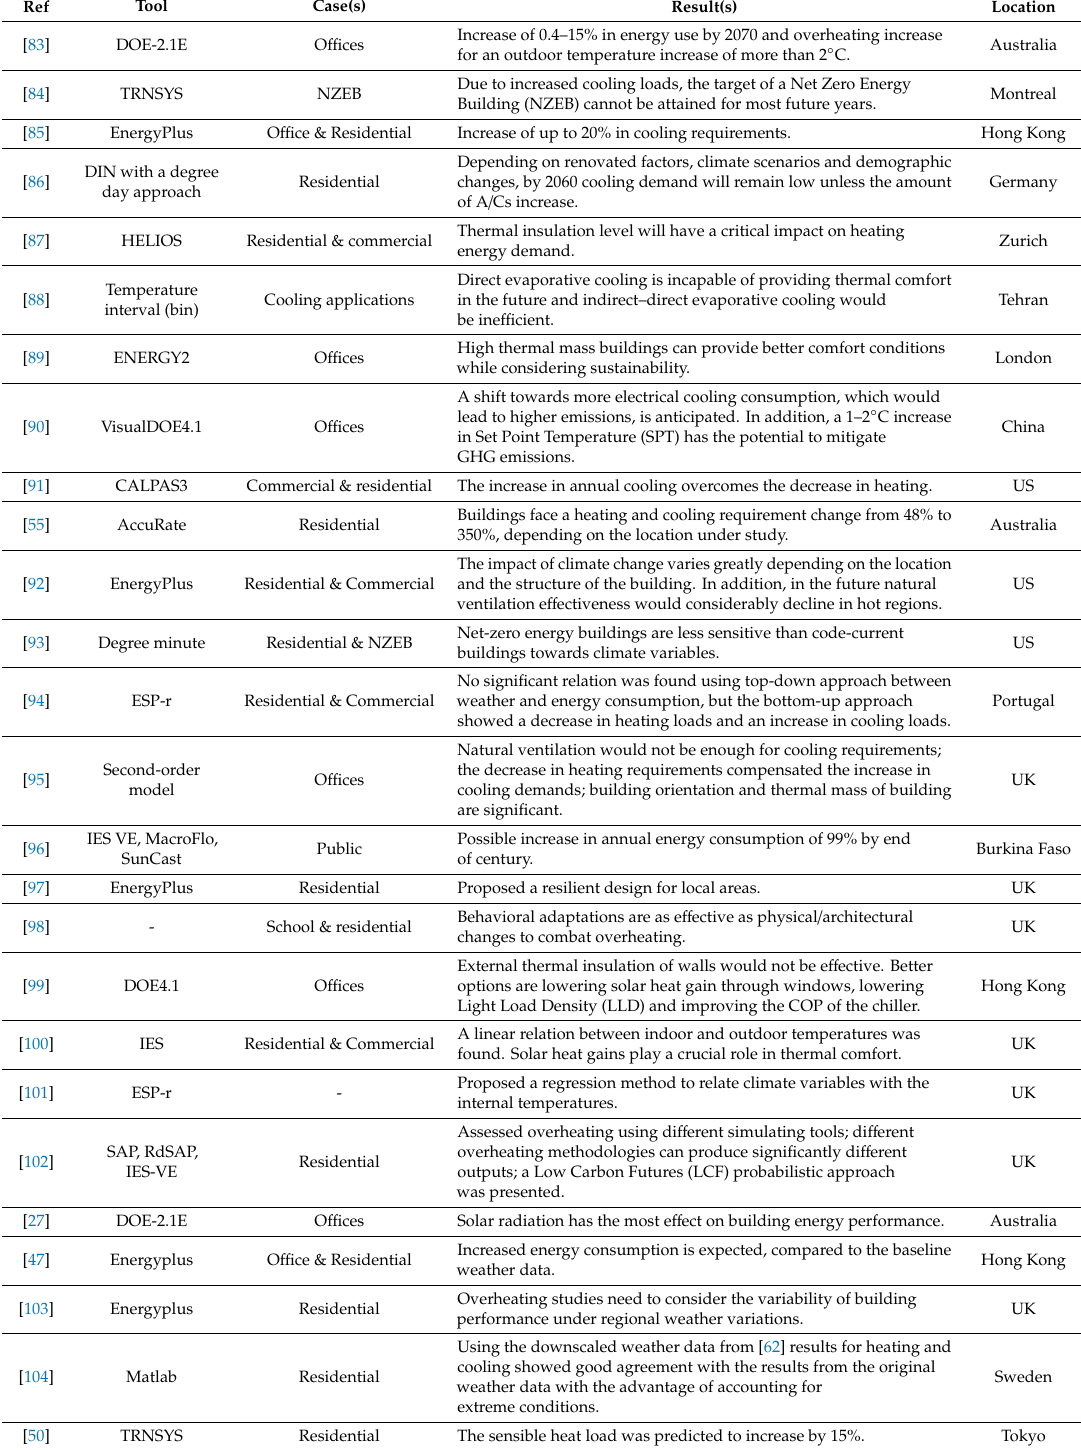
Table 3. Summary of research on building energy performance under future climate